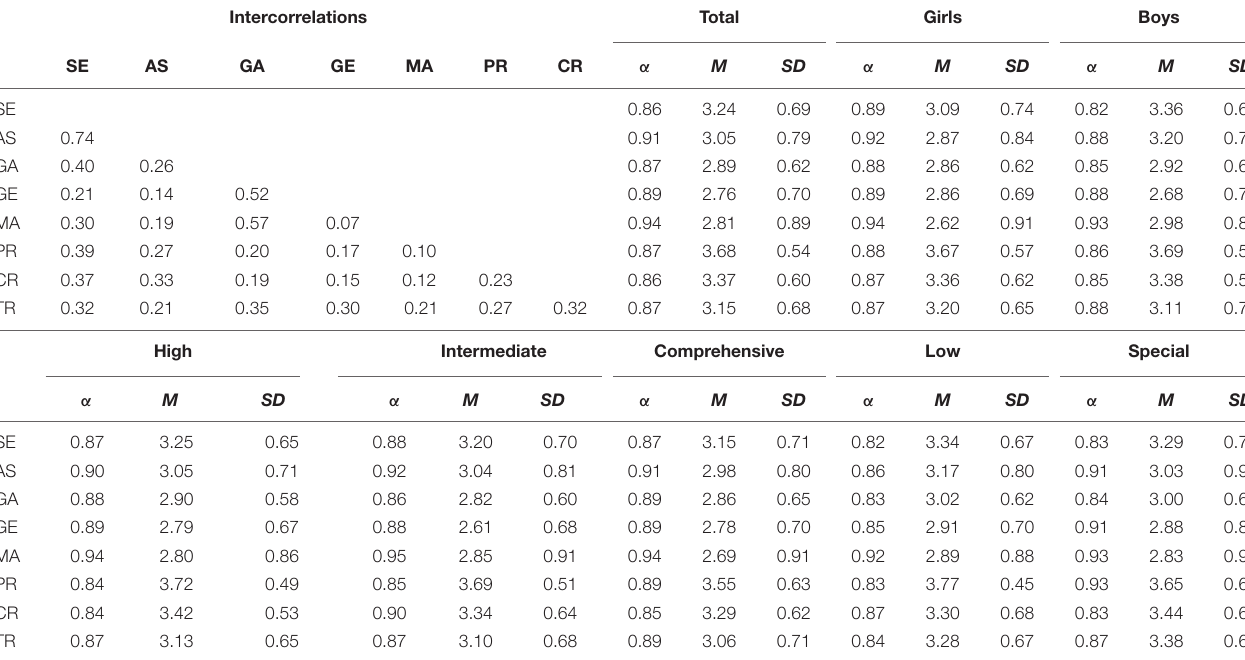
TABLE 1 | Intercorrelations (total sample), Cronbach’s alpha ( α ), mean ( M ), and standard deviations ( SD ) of the SC scales for the total sample ( N = 2950), for girls ( n = 1376) and boys ( n = 1574) and for the different ability tracks. Intercorrelations Total